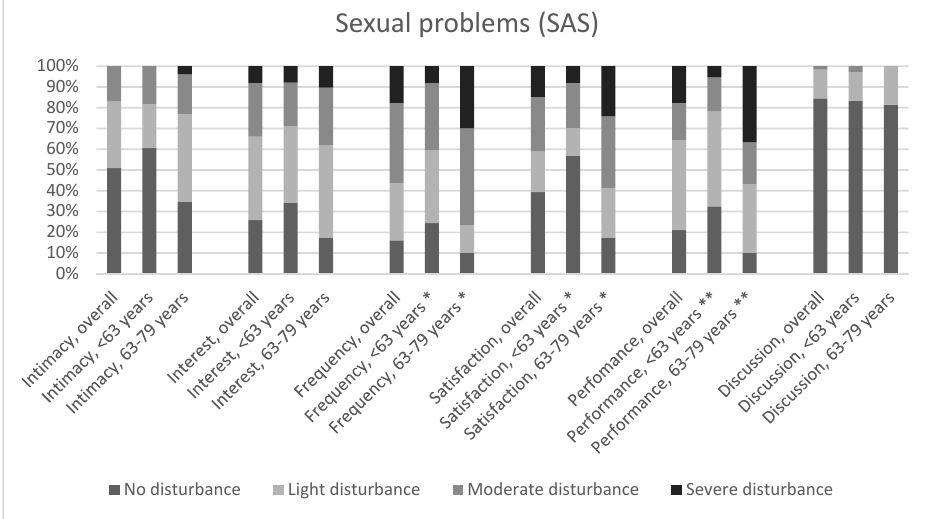
Figure 1. Experienced sexual problems. * Significant difference based on age at p < 0.01 level; ** significant difference based on age at p < 0.001 level. SAS, sexual adjustment scale.